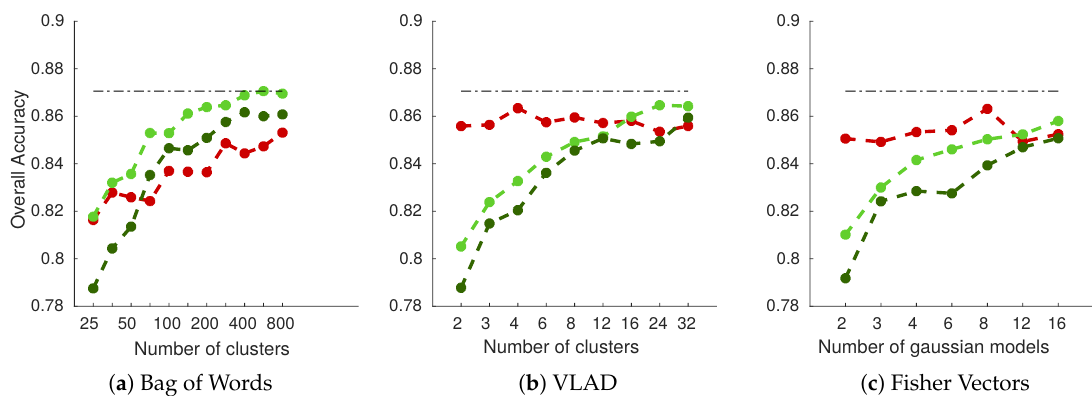
Overall accuracy on the white cultivar database as a function of the number of clusters/models used in the SIFT encoding part: ( a – c ) the three types of encoding considered in the experiment. RGB fusion was used, concatenating each channel features into one final feature vector. Red Curve: DoG SIFT (keypoints); Light Green Curve: Dense SIFT (grid); Dark Green Curve: PHOW SIFT (multiscale grid); Dotted line: Best overall